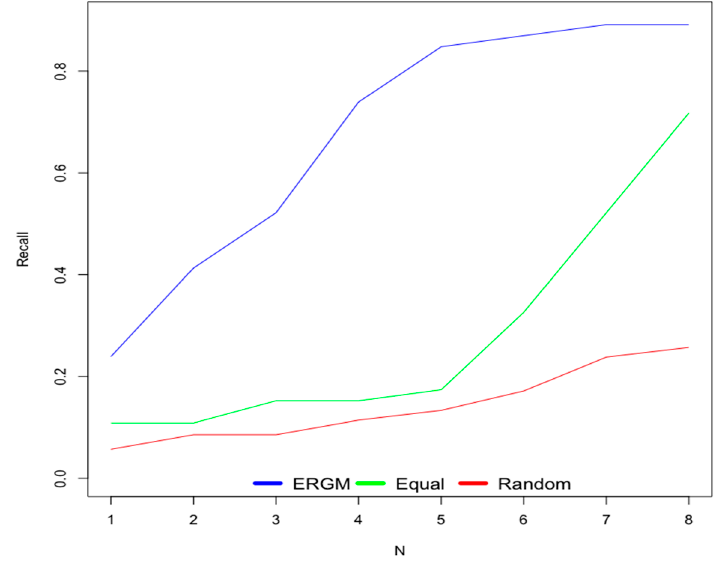
Figure 9. Recall for new users.